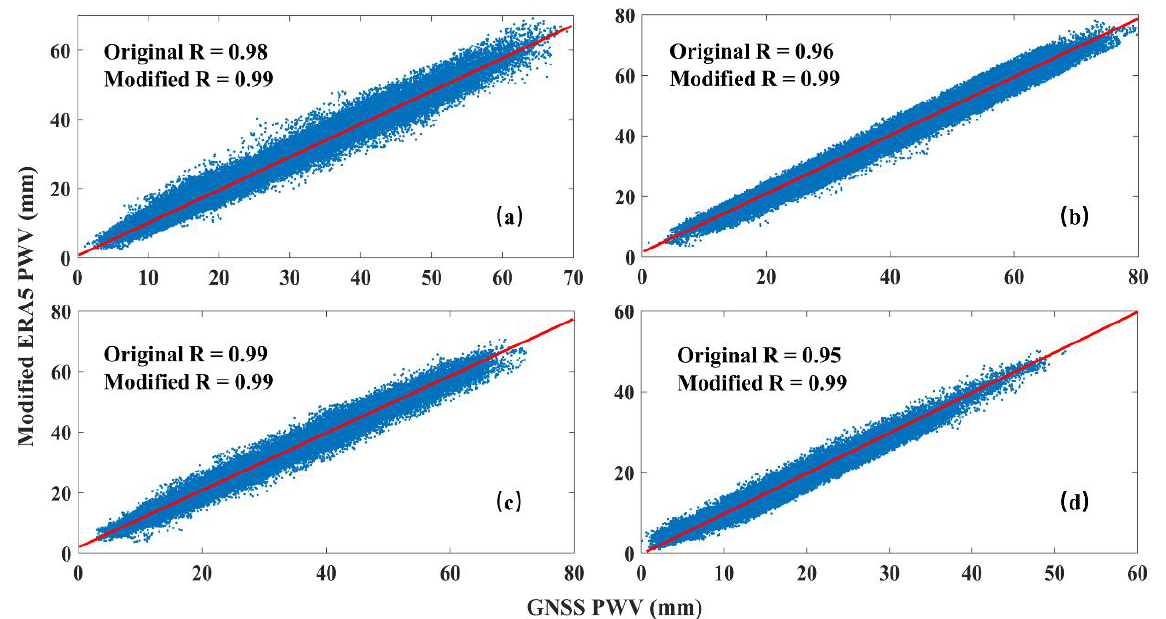
Figure 11. SMC regional validation station ERA5 PWV and GNSS PWV scatter plots. ( a – d ) Spring, summer, autumn, and winter, respectively.